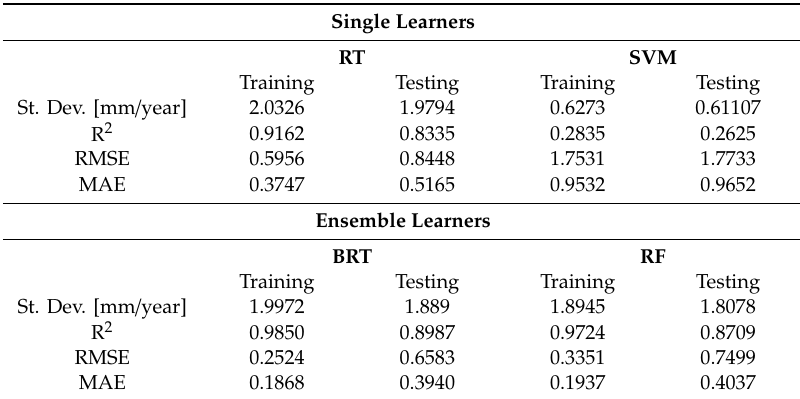
Table 7. Performance of MLAs trained with all the input